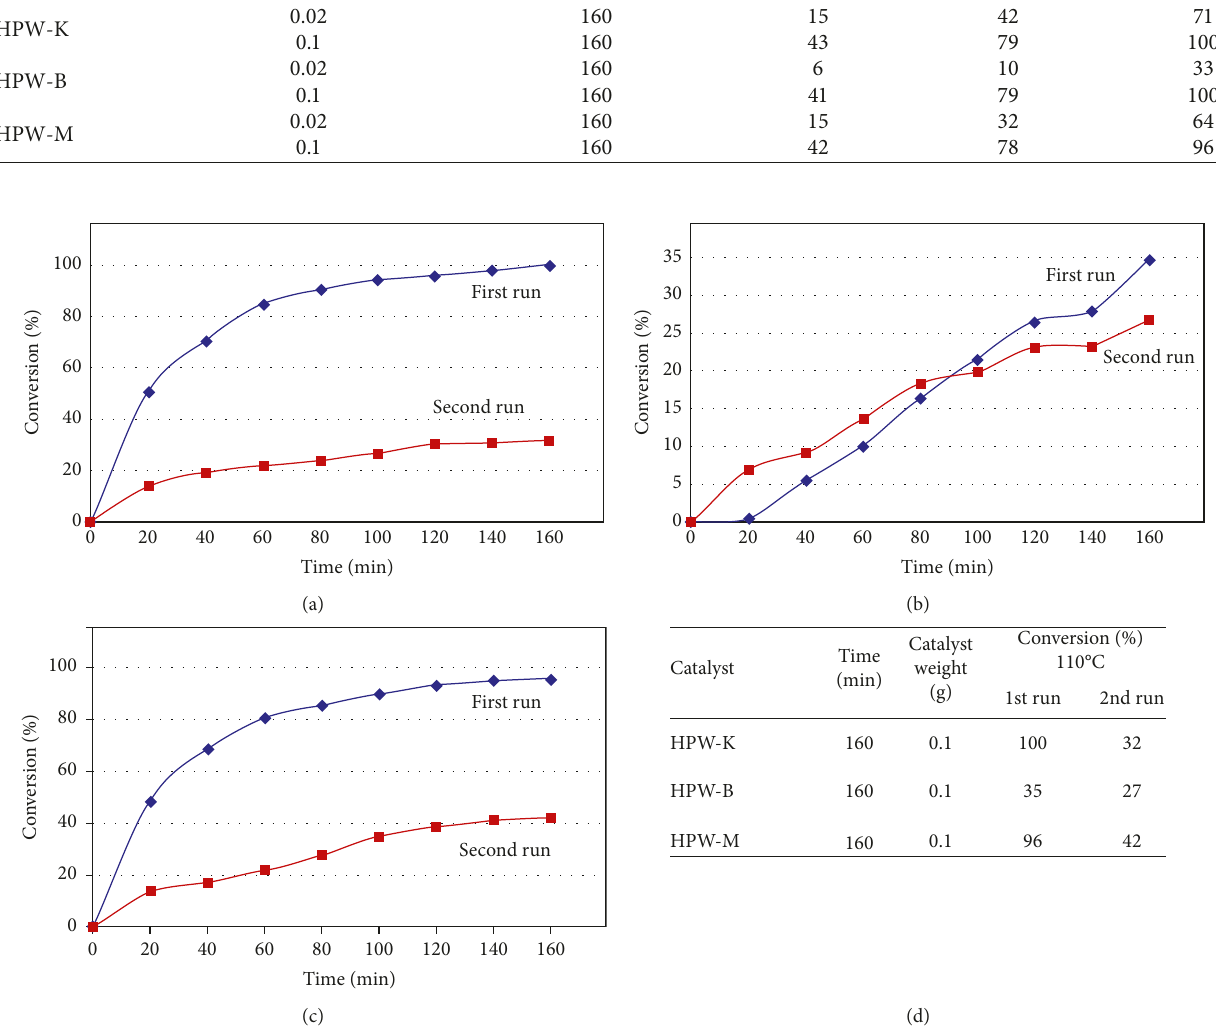
Table 3: Effect of temperature on the catalytic activities of supported HPW catalysts for the esterification of acetic acid with heptanol. Catalyst